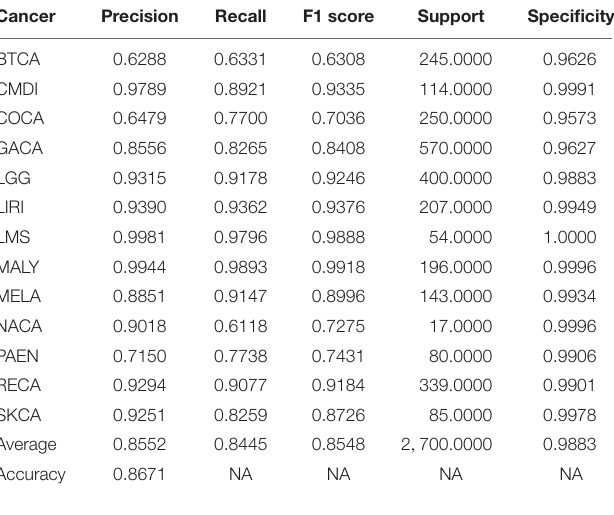
TABLE 2 | Performance metric of training dataset using top 500